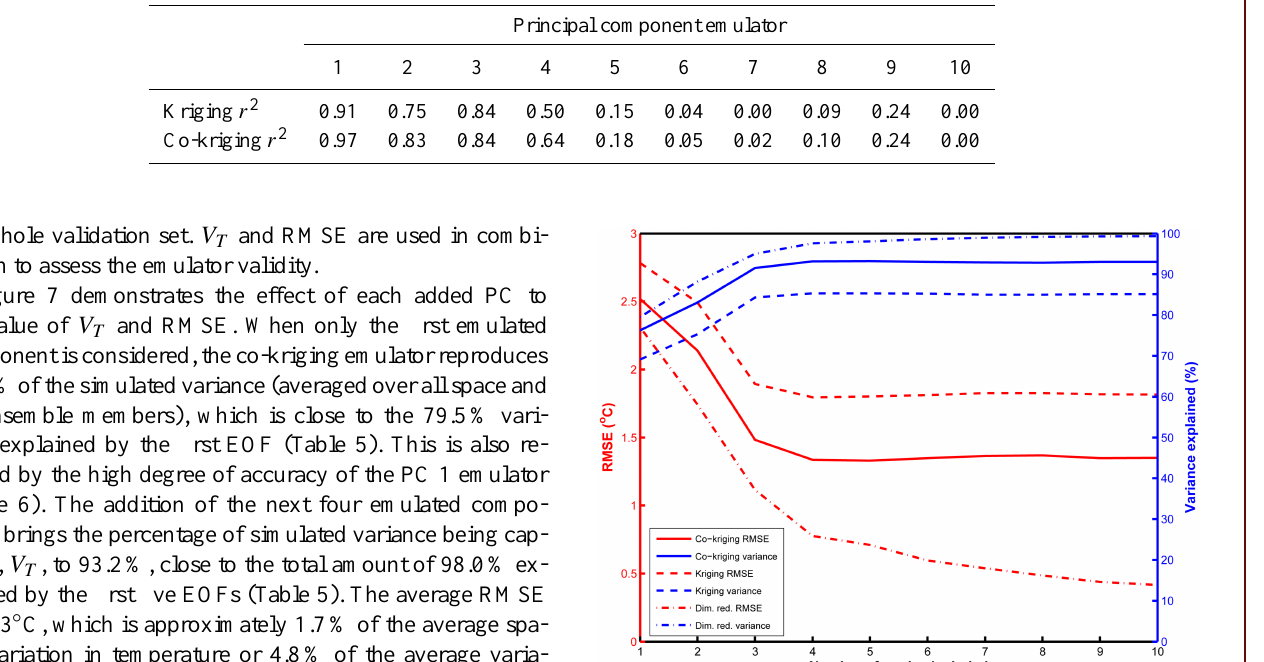
Table 6. Validation of each PC emulator using the 59-member ensemble. The correlation coefficients show how well matched the emulated PCs are compared with the simulated values. The co-kriging emulator uses 50 expensive points and 150 cheap points while the kriging emulator here uses the same 50 expensive points.